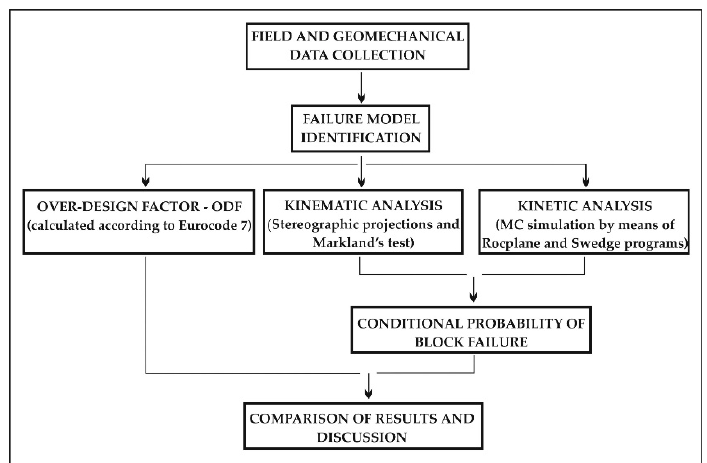
Figure 1. Flowchart showing the adopted procedure.